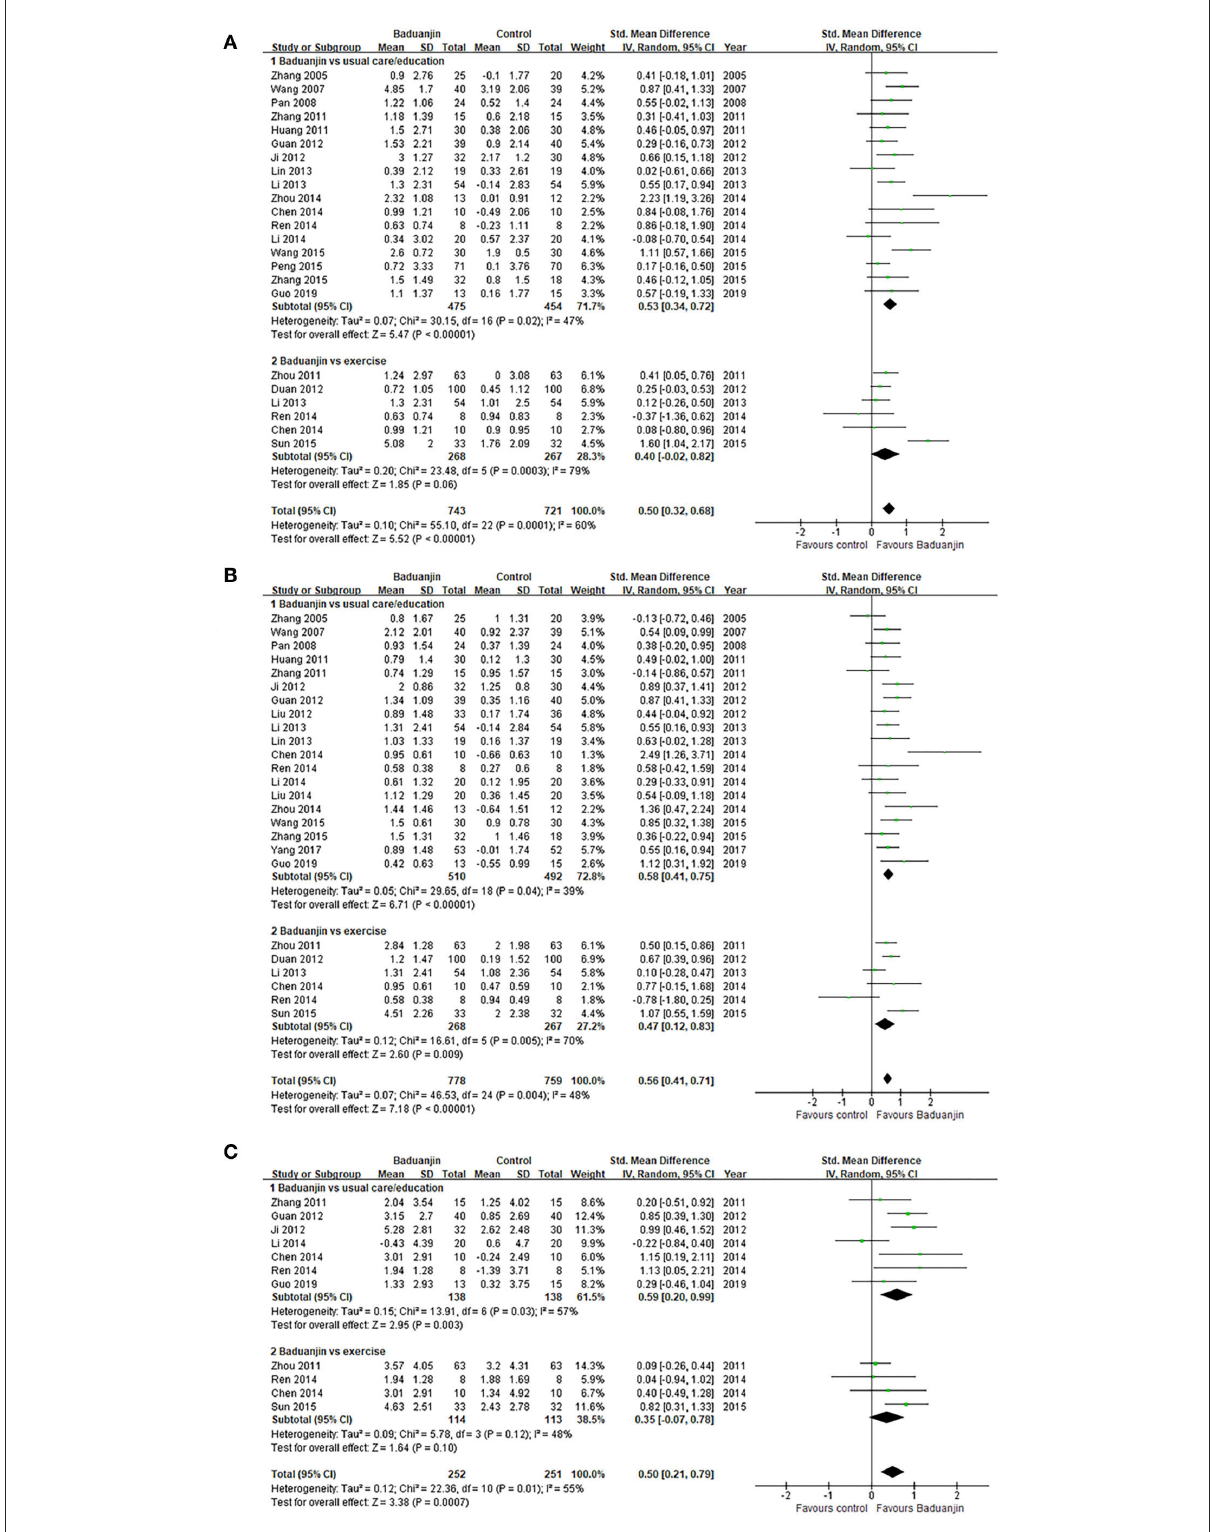
FIGURE4 Forest plot of the effects of Baduanjin exercises on Glycemic control. (A) fasting blood glucose, (B) glycosylated hemoglobin, (C) 2-h postprandial blood glucose.